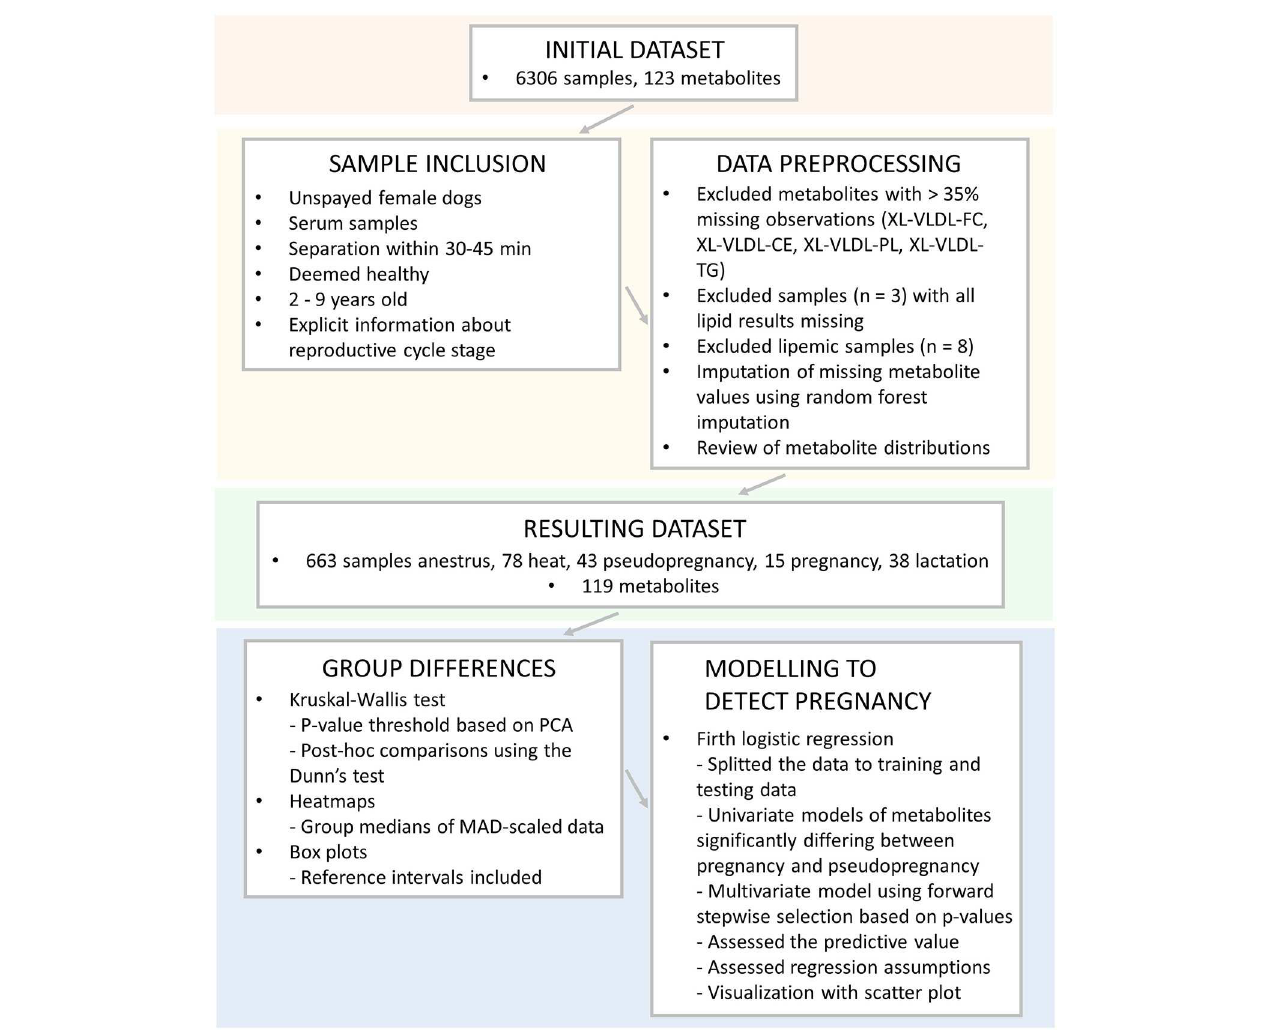
FIGURE2 Overview of the used samples, inclusion criteria, data preprocessing, and statistical analyses utilized in this study. XL-VLDL, Very large very low-density lipoprotein; -FC, free cholesterol; -CE, esterified cholesterol; -PL, phospholipids, -TG, triglycerides; PCA, Principal component analysis; MAD, median absolute